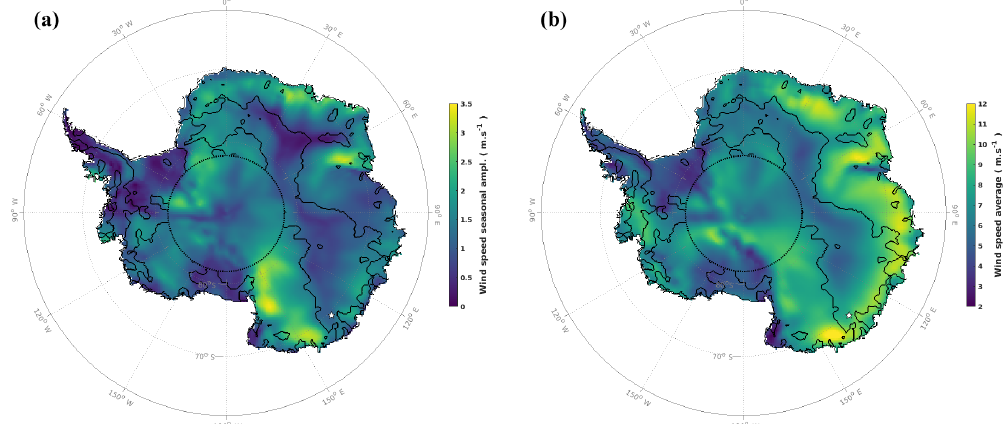
Figure 10. Seasonal wind speed amplitude (a) and average (b) . Data are extracted from ERA-Interim reanalysis provided by ECMWF on 25 × 25km 2 grid cells, from the period 2002 to 2010 corresponding to the ENVISAT lifetime. Black contour lines delineate regions where the backscattering coefficient at the Ku band peaks before April. The white star shows the location of the time series plotted in Fig. 1. No observations are available beyond 81.5 ◦ S (black dotted